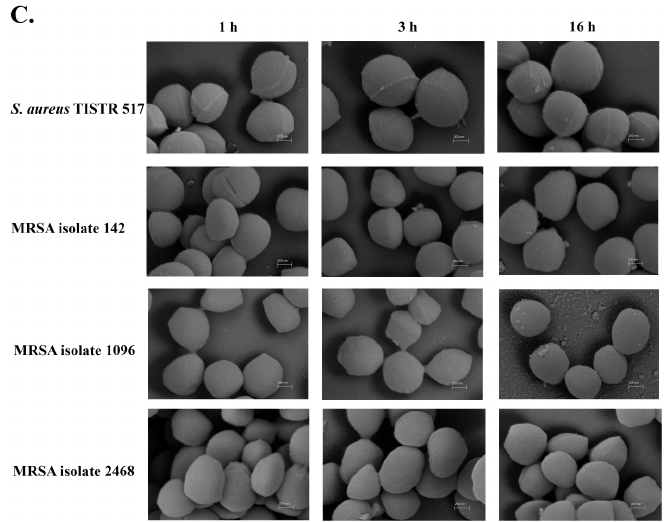
Figure 6. SEM micrograph of bacterial pathogens after the treatment of anti-MRSA peptide (P1). S. aureus TISTR 517 and MRSA isolates 142, 1096, and 2468 were treated with ( A ) P1 and ( B ) vancomycin at the 1× MIC level for 1, 3, and 16 h and compared to ( C ) the non-treatment condition.